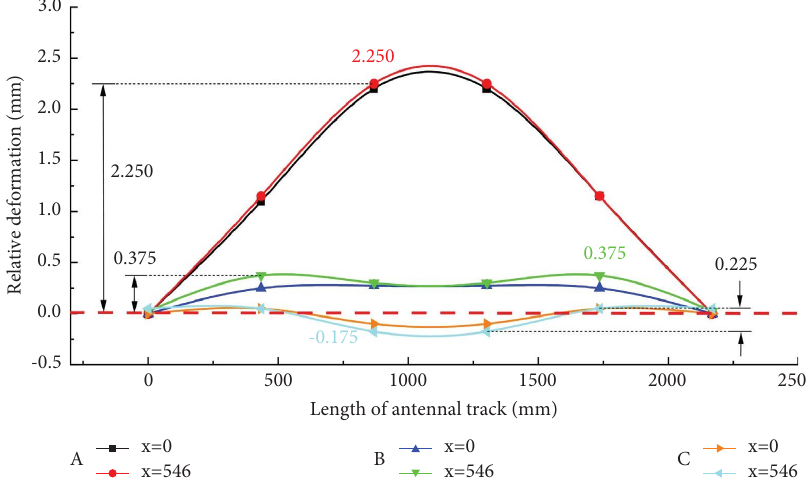
Figure 9: Deformation and fatness of the antenna’s azimuth track.